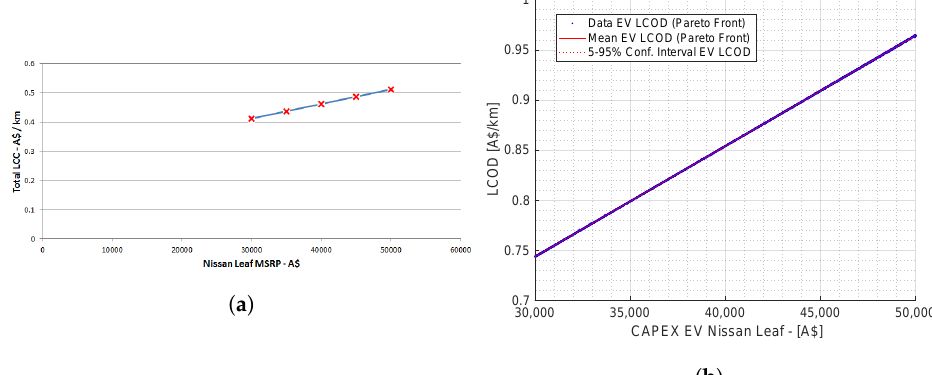
Figure 8. Total LCC and LCOD versus CAPEX. ( a ) Results with Method of [12] with LCC. ( b ) Results with proposed method